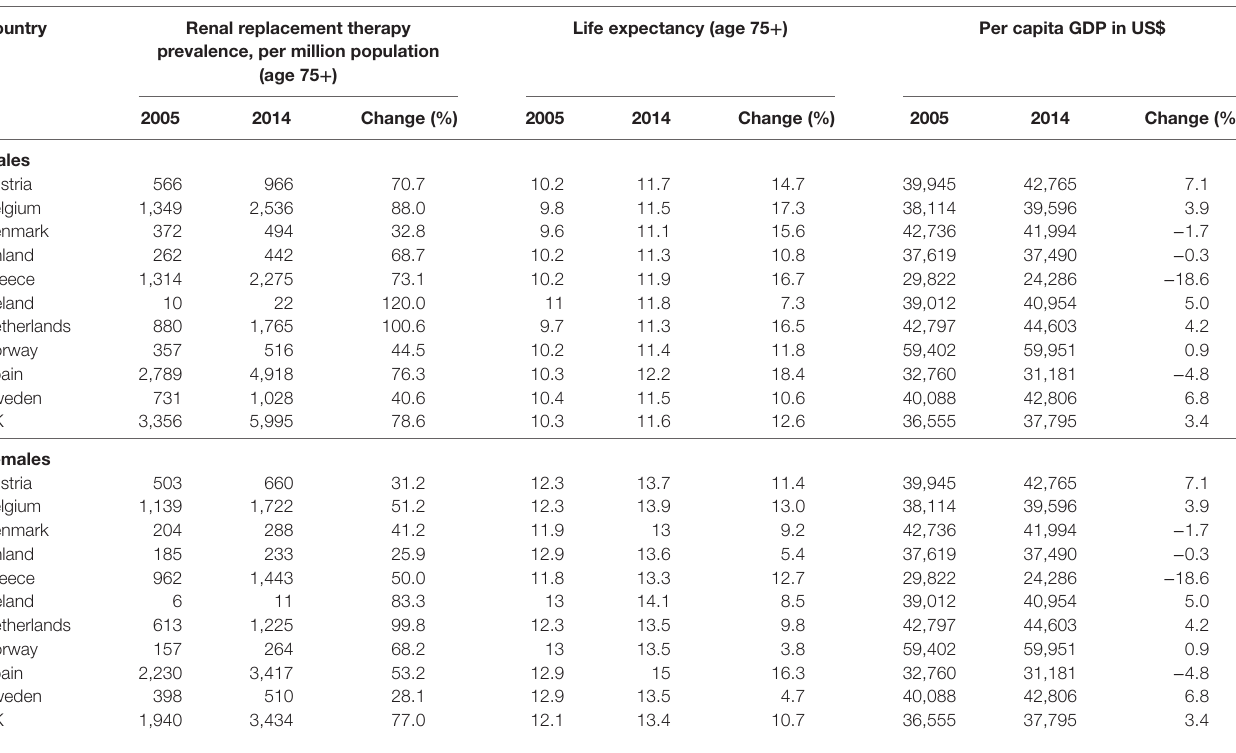
TaBle 1 | Descriptive statistics of the study variables in 2005 and 2014 by sex and country. country renal replacement therapy prevalence, per million population